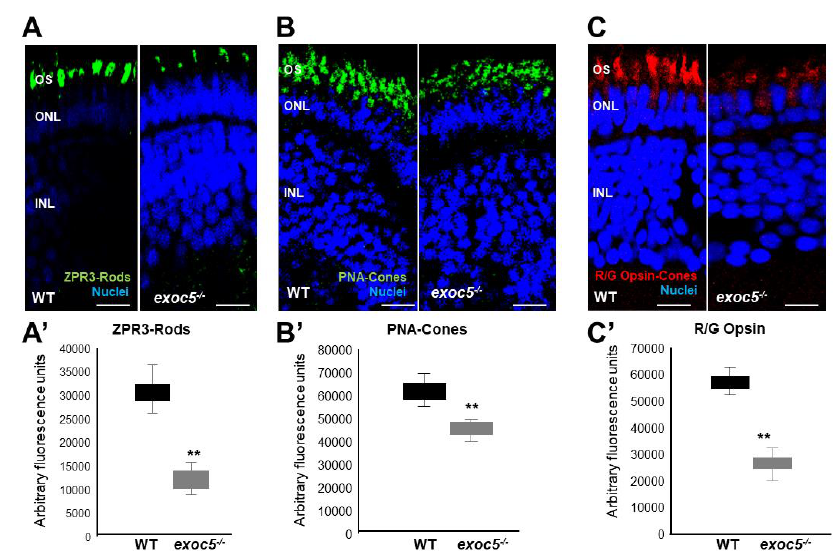
Figure 2. Immunohistochemical analysis of rod and cone photoreceptors in wild-type and exoc5 −/− mutant zebrafish. Rod photoreceptor outer segments were identified with ZPR3 antibody (green, ZPR3, ( A )), cone photoreceptors with PNA-lectin-488 (green, PNA, ( B )), and medium-wavelength R/G cone opsins (red, R/G Opsin, ( C )), all at 3.5 dpf. Loss of rod and cone OS immunofluorescence was noted in exoc5 −/− mutant zebrafish. Scale bars = 50 μ m ( B ) and 25 μ m ( A , C ). OS, outer segments; ONL, outer nuclear layer; INL, inner nuclear layer. ( A’ – C’ ) Image J was used to quantify immunofluorescence for the 3 OS markers. ** p < 0.005 (WT vs. exoc5 −/− mutants).